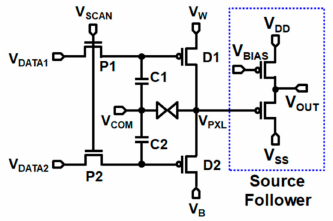
Figure 8. Schematic of a source follower circuit to measure V PXL .